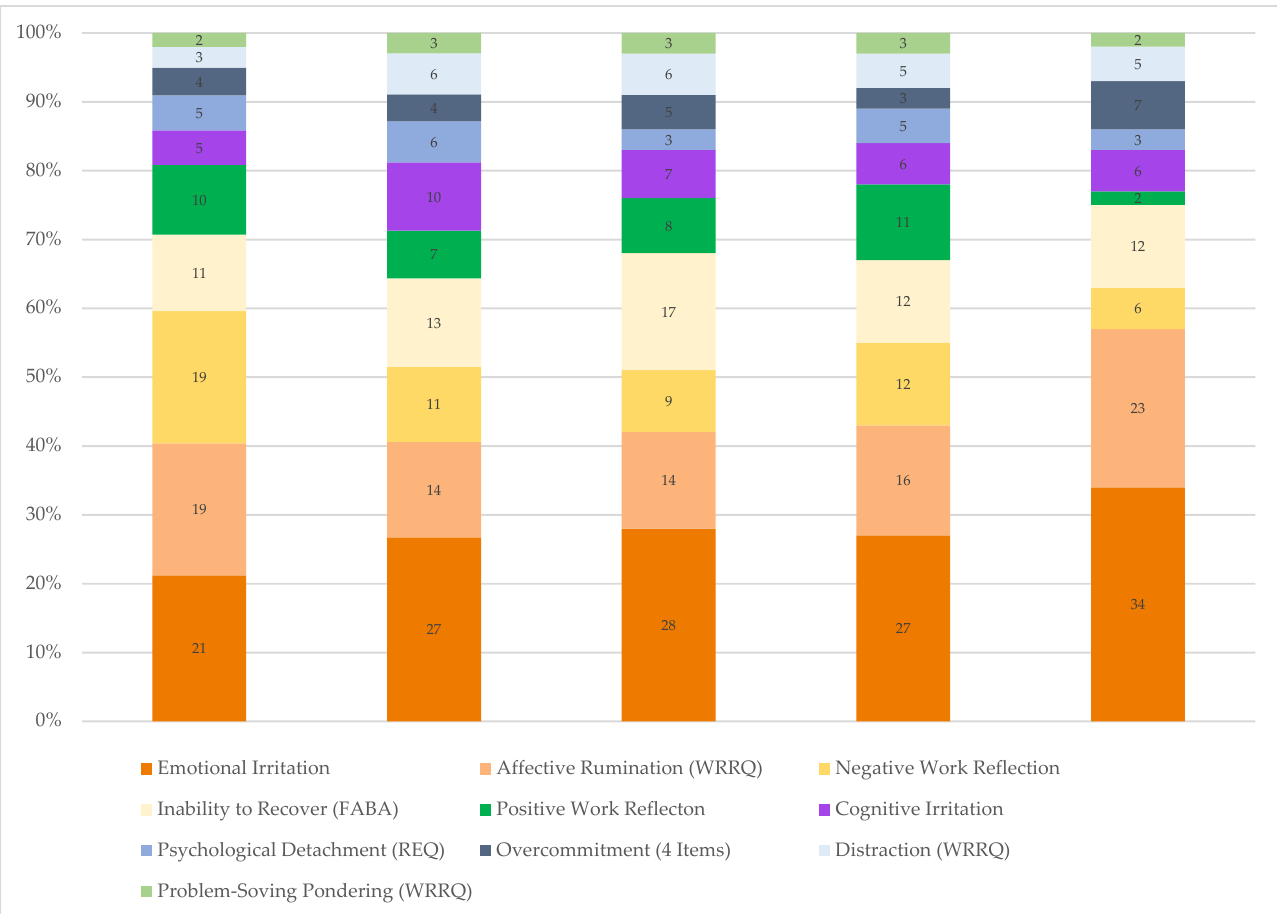
Figure 1. Work-Related Rumination Constructs and Relative Explained Variance in Well-being and Health Outcomes. Note. Overcommitment (4 Items) = composite of items 2, 3, 4, and 5; REQ = recovery experience questionnaire; WRRQ = work-related rumination questionnaire; FABA = faulty attitudes and behaviors analysis.